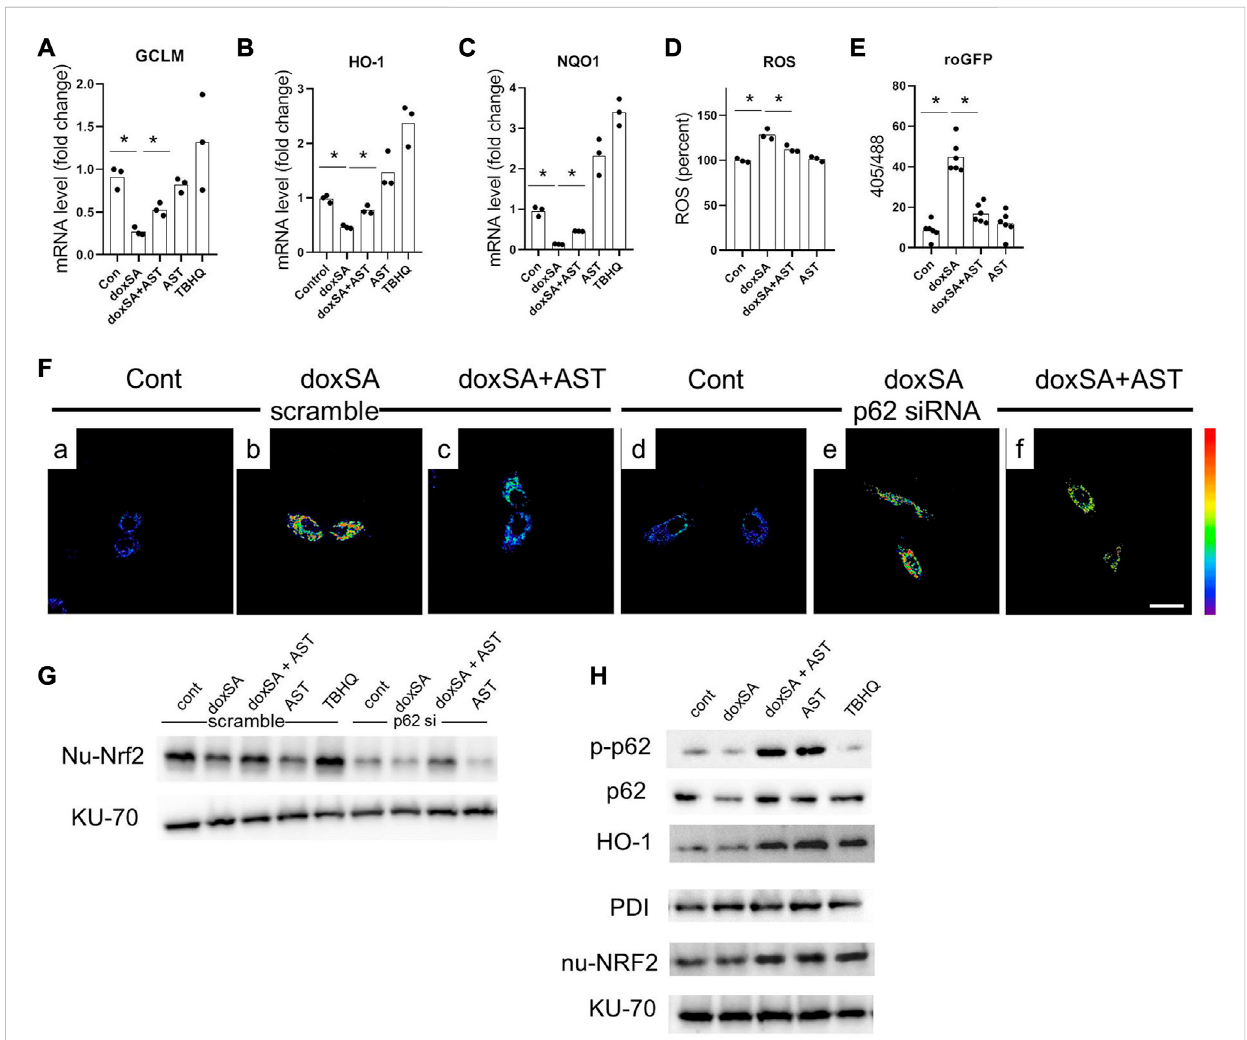
FIGURE 6 ASTinhibitedoxidativestressthroughmodulatingp62-NRF2signalingpathway.mRNAexpressionof (A) GCLM, (B) HO-1,and (C) NQO-1intheHK- 2 cells after exposure to the different treatments. n = 6/group. The data shown are means ± SD, one-way ANOVA with Bonferroni ’ s test. Quantitative analysis of (D) intracellular ROS, and (E) roGFP in the HK-2 cells with different treatments. n = 6/group. The data are means ± SD, one-way ANOVA with Bonferroni ’ s test. (F) Representative images of mitochondrial ROS sensing in HK-2 cells in (a – c) scramble siRNA and in (d – f) p62 siRNA-transfected HK-2 cells after exposure to thedifferenttreatments (scale bar 100 μ m). (G) Representative WB images for thenuclear Nrf2 (nu-Nrf2)and Ku-70 of